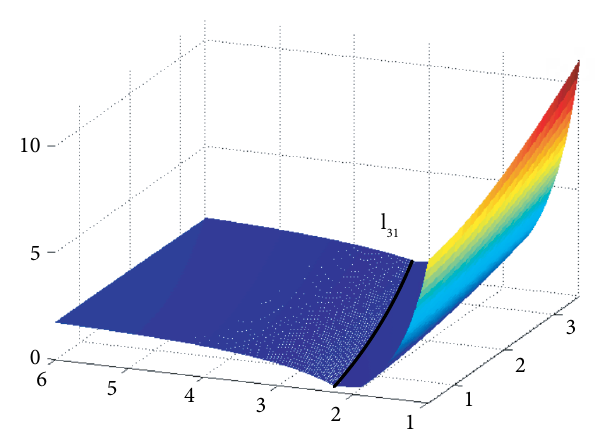
Figure 5. The relationship between parameters u and r